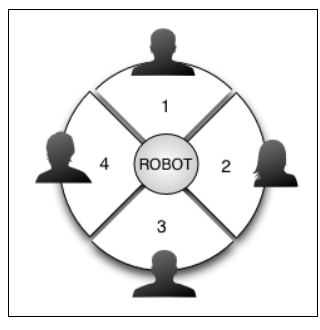
Figure 11. User Localization steps. ( a ) The user starts to talk to Maggie; ( b ) The User Localization System, using the received sound signals from the microphones, decides the angle of the user; ( c ) Maggie rotates toward the user position; ( d ) The Dialog Manager based on the observations from the proxemics studies (see Figure 6), the user localization information (with the laser sensor), and the user profile (load later to identify the user)